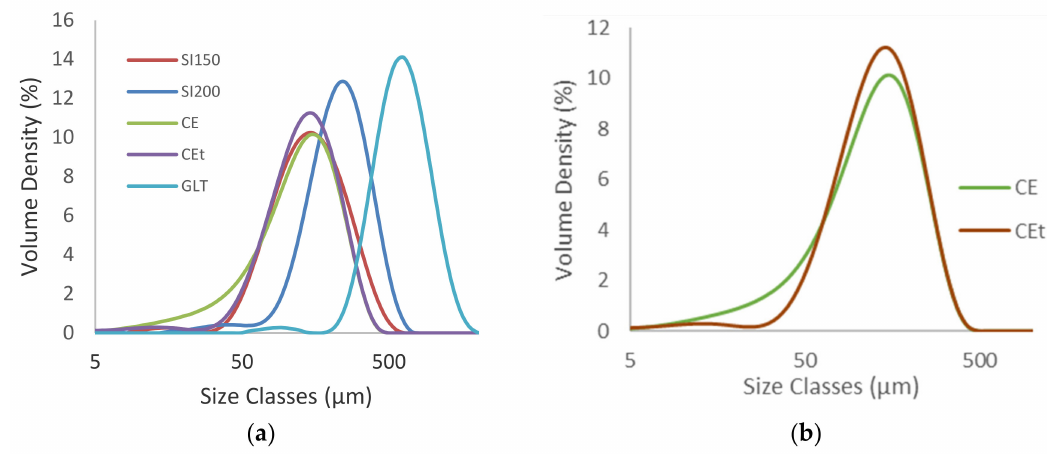
Figure 3. PSD comparison of D-Sorbitol CE, CE T , SI150, SI200 and GLT powders ( a ) and focus on CE D-Sorbitol sieved (red) and nonsieved (green) ( b